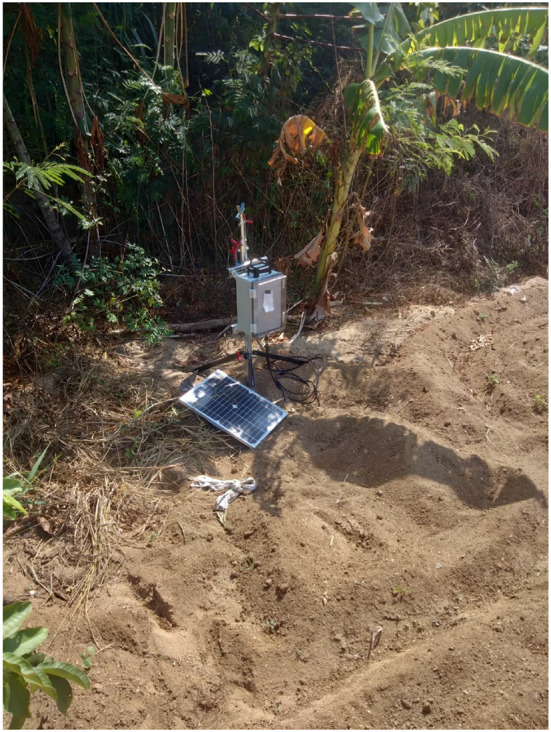
Experimental area.